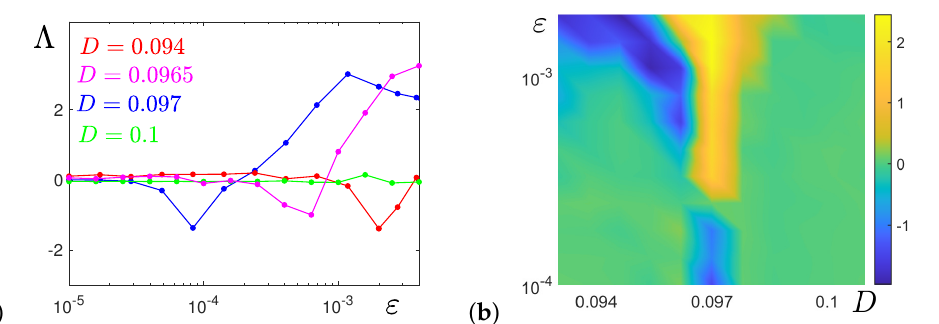
Figure 9. Largest Lyapunov exponent Λ for the stochastic system (2): ( a ) versus parameter ε for different D ; ( b ) colored ( D , ε